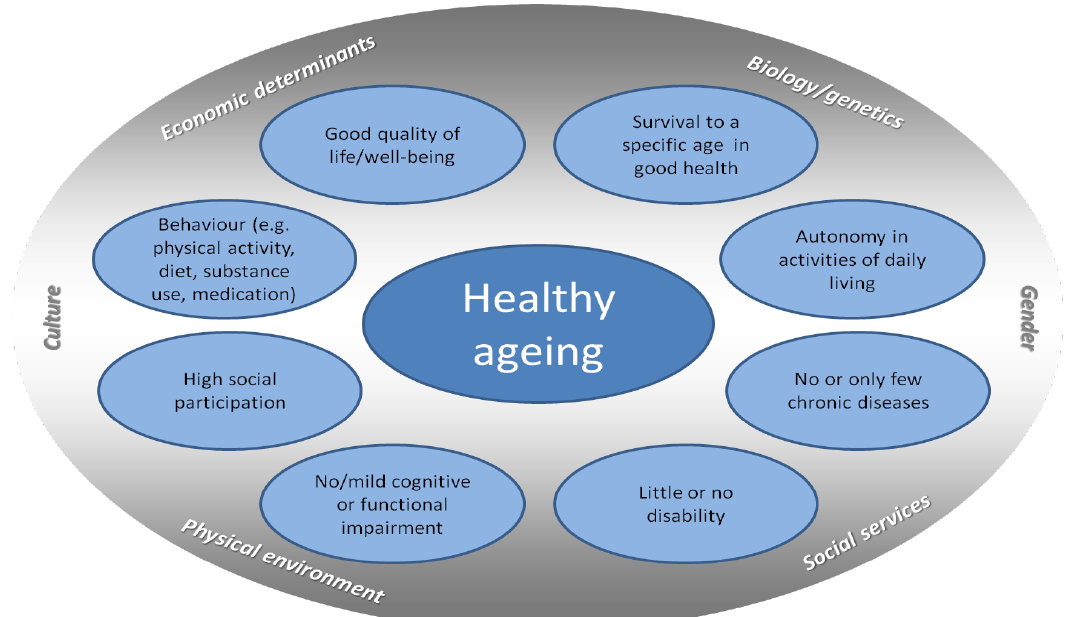
Figure 1. Components of healthy